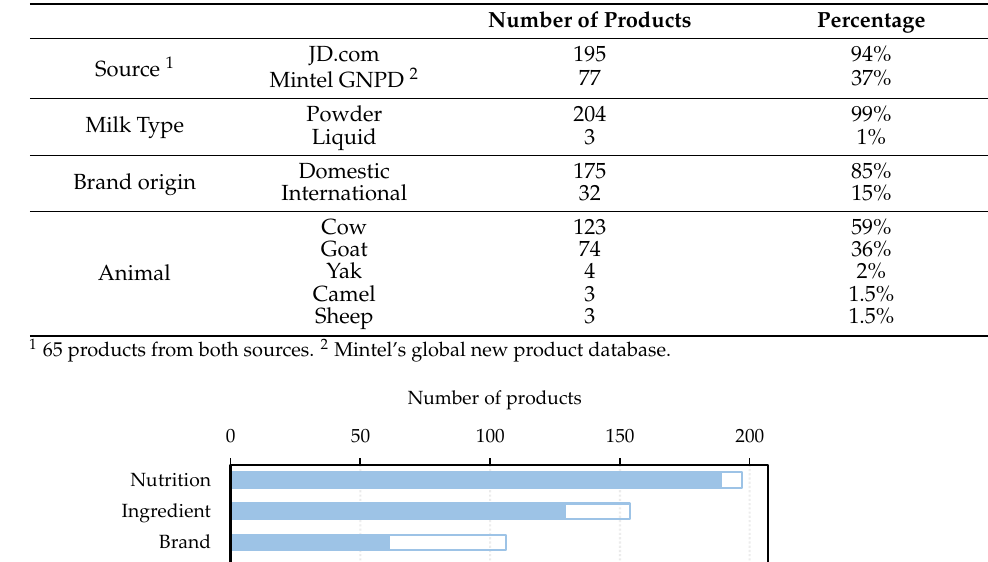
Table 3. Summary of eligible products.